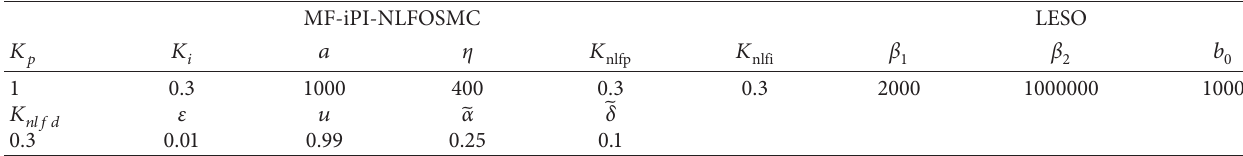
Table 4: Key parameters of the MF-iPI-NLFOSMC.